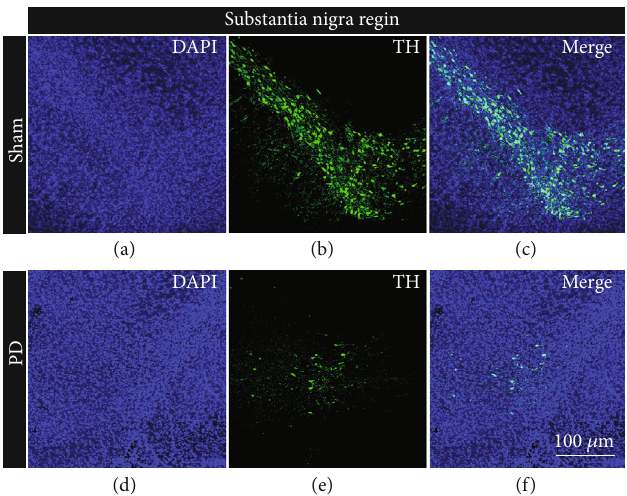
Figure 6: Modeling success. (a – c) The pictures are the coronal sections of the substantia nigra compact part (AP: − 5mm, ML: 2 mm, and DV: 7.9mm) of the control group rat under di ff erent conditions (DAPI, TH, and merge). (d – f) The pictures are the coronal sections of the SNC part (AP: − 5mm, ML: 2mm, and DV: 7.9 mm) of the experimental group rat under di ff erent conditions (DAPI, TH, and merge). Scale bar 100 μ m.